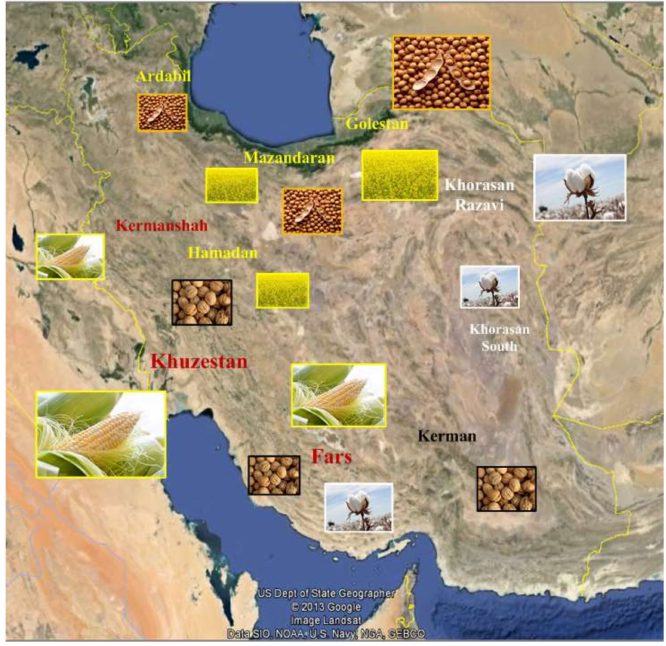
Figure 3. Important regions in Iran for the plantation of oil